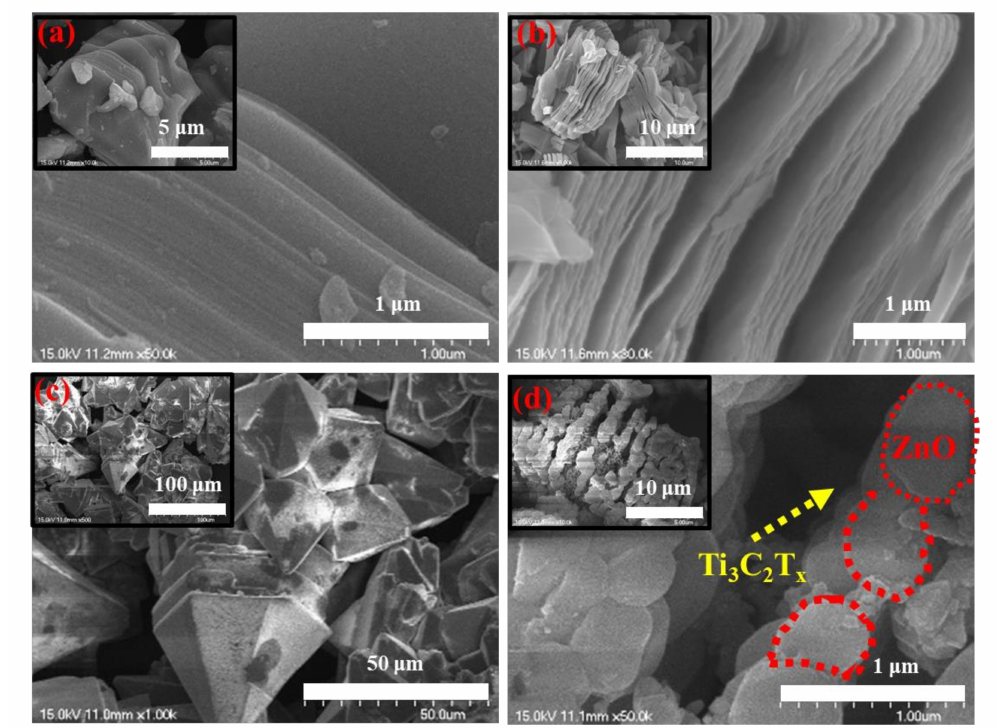
Figure 2. SEM images of ( a ) Ti 3 AlC 2 MAX phase, ( b ) Ti 3 C 2 T x MXene, ( c ) pure ZnO, and ( d ) ZnO / Ti 3 C 2 T x hybrid structure. The insets show low-magnification SEM